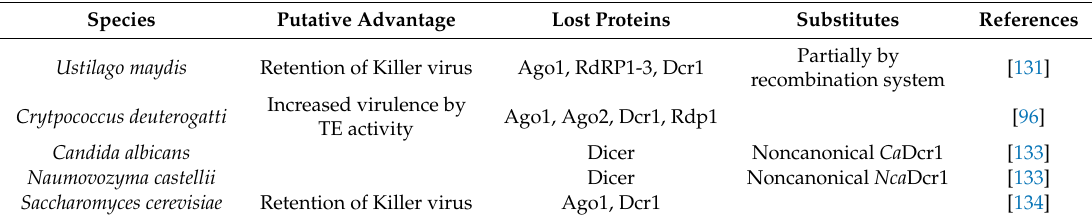
Table 3. Loss of the RNAi mechanism among fungi